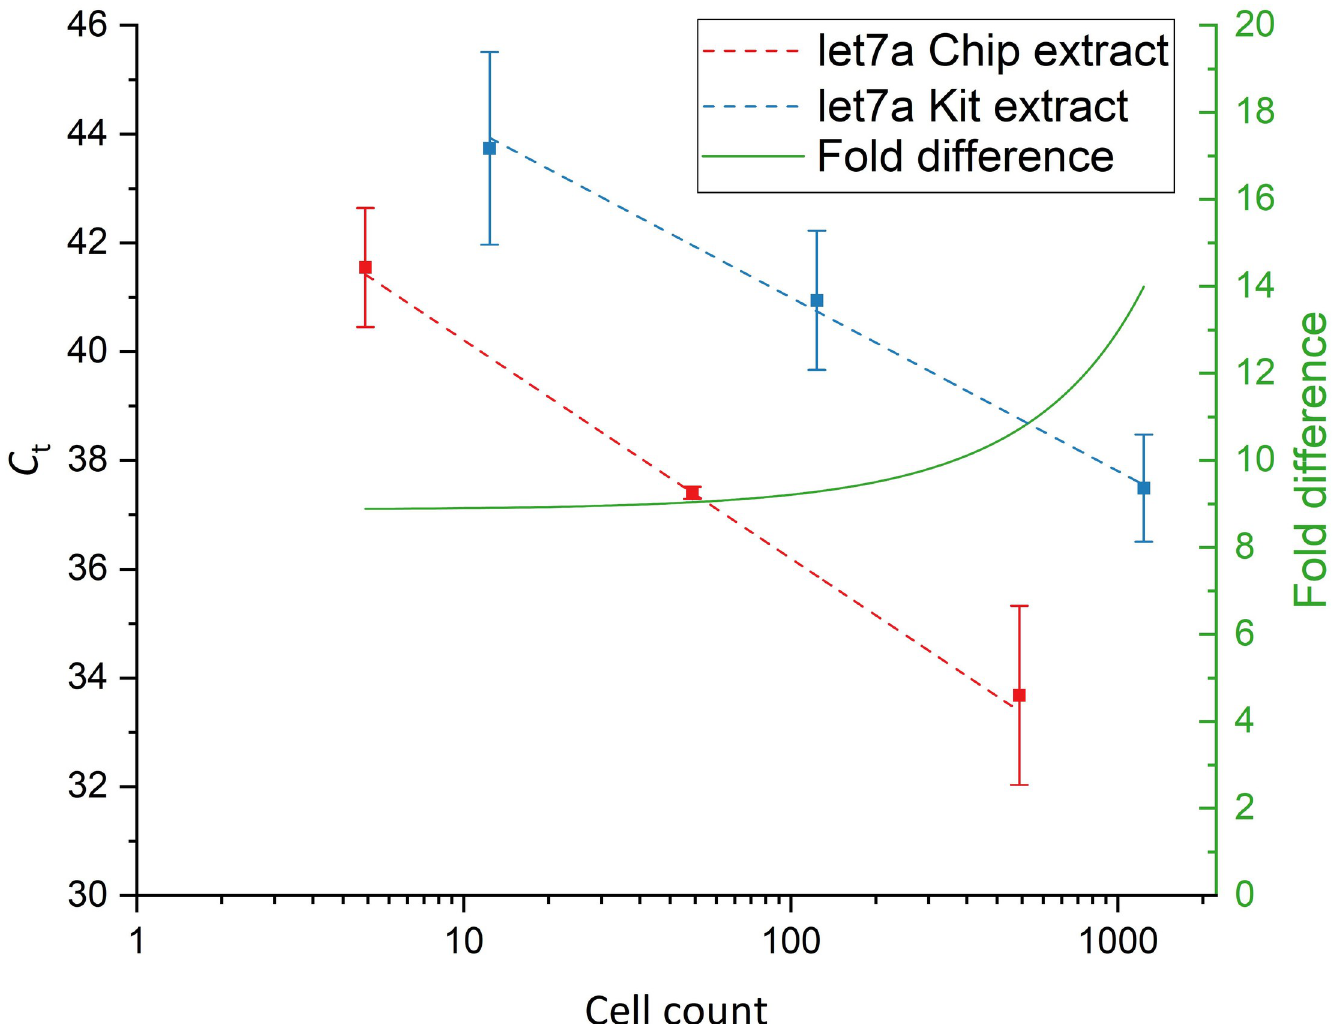
Fig 10. Analysis of MCF7 extracts for let7a. Red: Chip extracts; Blue: Kit extracts. Linear fits (dashed lines) are applied to the C t plots and the difference in detected miRNA concentrations was calculated by taking the differences of the linear fits (green, right axis) (n = 3).